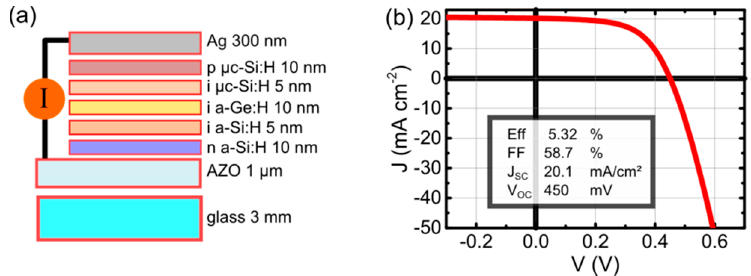
Figure 4. Layer stack ( a ) and JV -curve ( b ) of the reference solar cell with a 10 nm a-Ge:H absorber layer .